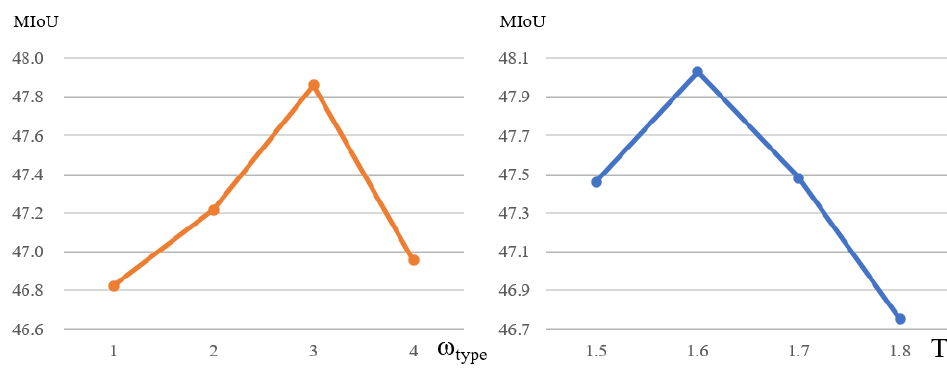
Figure 9. Parameter study on w type and T . Here w type = 1 means equally important, and 2, 3, and 4 indicate different degrees of importance.